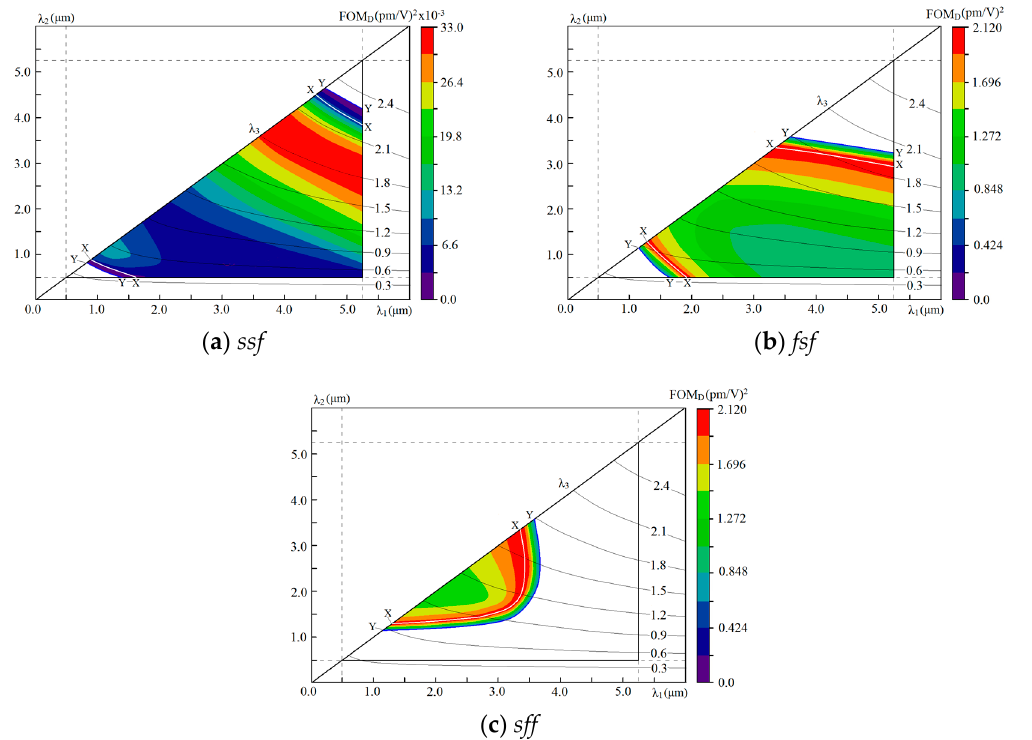
Figure 9. FOM D ( λ 1 , λ 2 ) distributions for RTA crystal for all types of interactions: ( a ) ssf , ( b ) fsf , ( c ) sff .